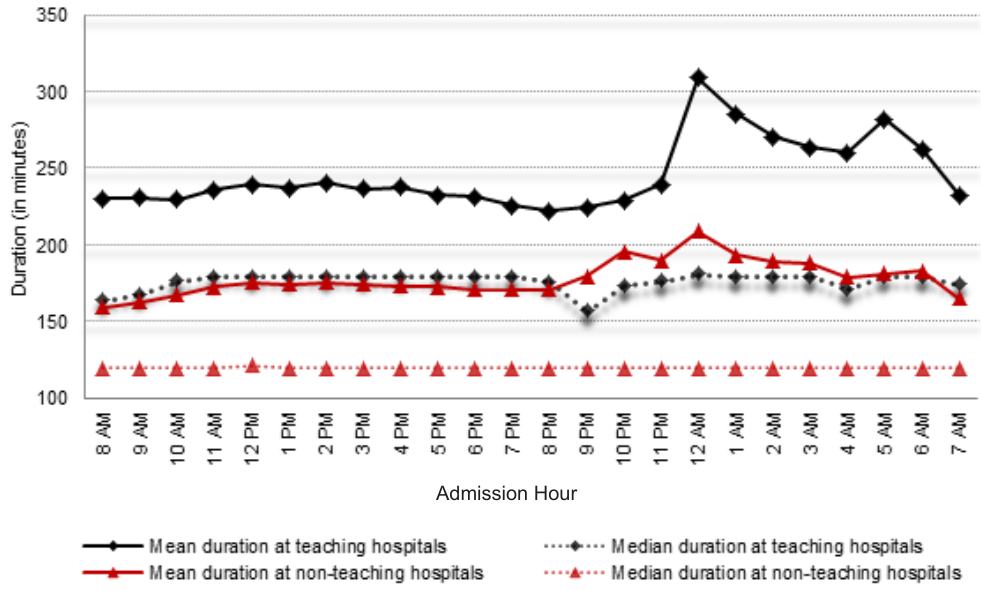
Figure 1. Mean and median duration of routine visits to the hospital emergency departments. Data include all hospital emergency department routine visits that are discharged for home or self care during 2008 in Arizona, Massachusetts, and Utah. Duration is measured in minutes as the difference between admission time and discharge time for each